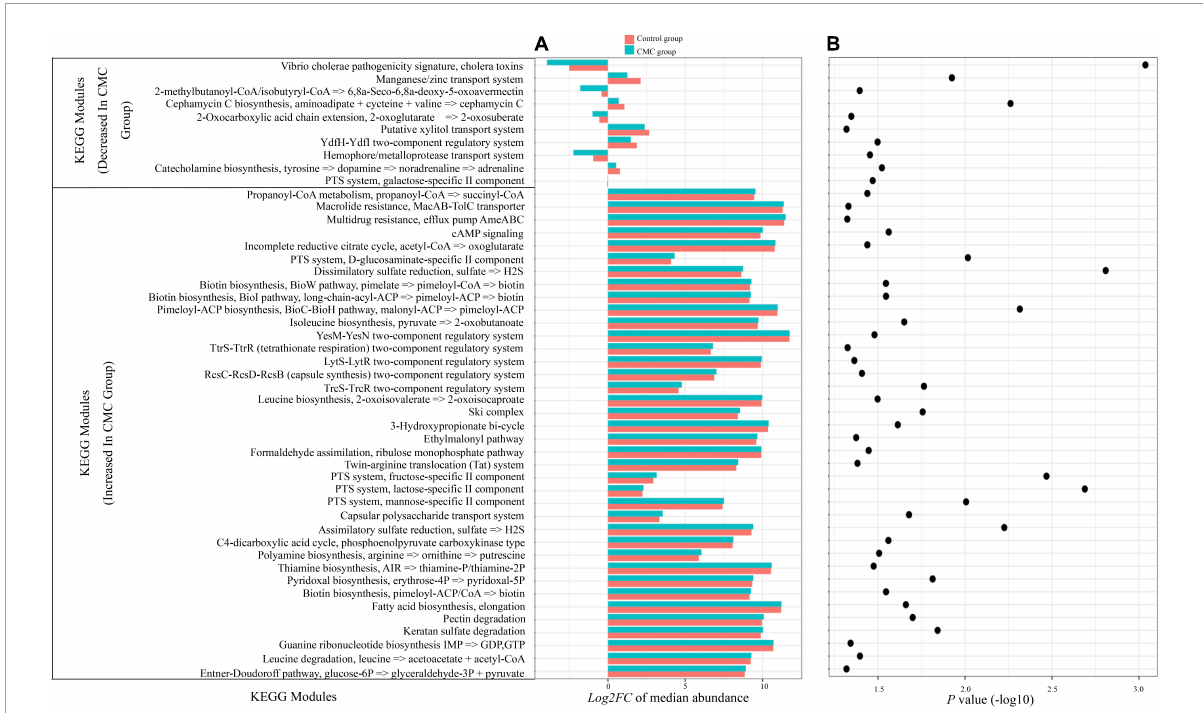
FIGURE6 CMC alters the functional potential of the gut microbiome. (A) Microbial genes annotated to Kyoto Encyclopedia of Genes and Genomes (KEGG) orthologs (KOs). The bar chart displays the log2 fold change of the relative abundance median of all individual KOs within a module following the Control group (pink bars) or the CMC group (blue bars), respectively. (B) Dot plot of the negative log10 of the P-value from the Mann–Whitney test of KEGG module abundance of two groups.